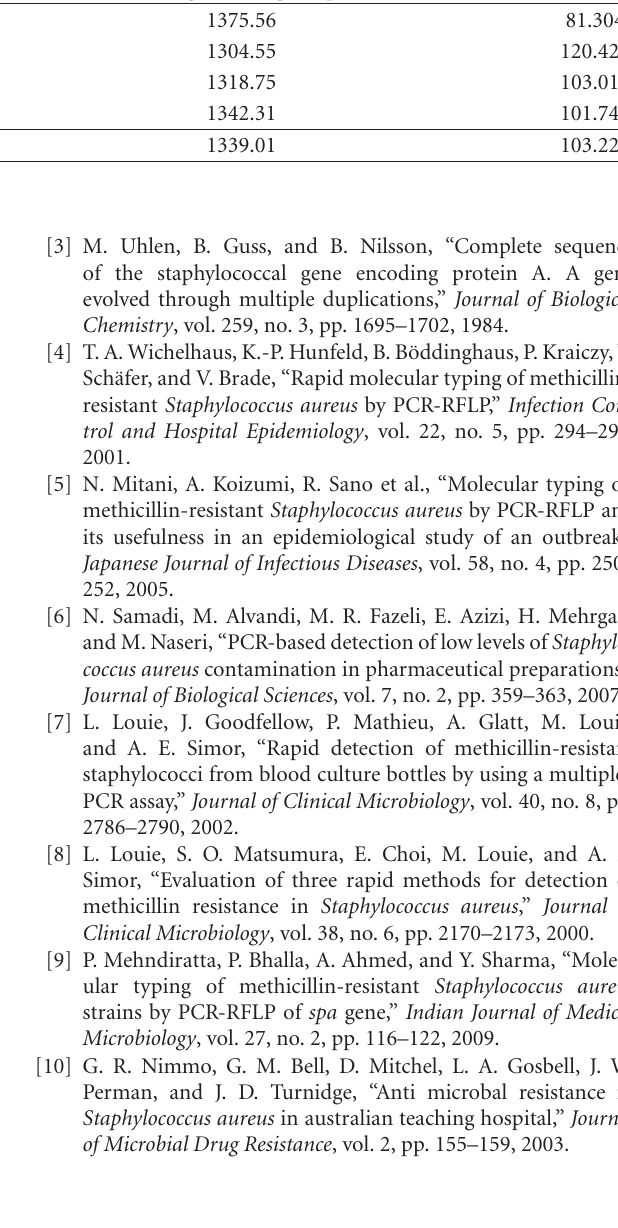
Table 4: Average length of spa gene in Staphylococcus aureus isolated from patient in Gorgan, north of Iran. Sample Number of isolated S.